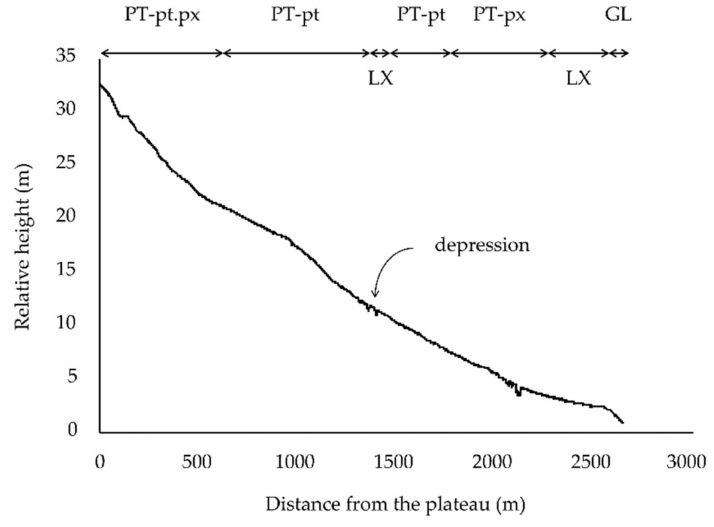
Figure 4. Soil toposequence along the line transect. PT − pt.px: pisoplinthic petric Plinthosols; PT − pt: petric Plinthosols; PT − px: pisoplinthic Plinthosols; LX: Lixisols; and GL: Gleysols.